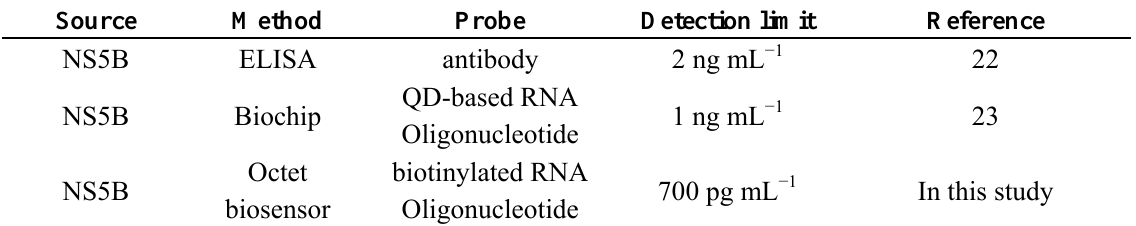
Table 1. The method and limitation for detection of HCV viral